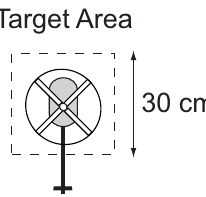
Figure 6. Proposed experiment for hovering.